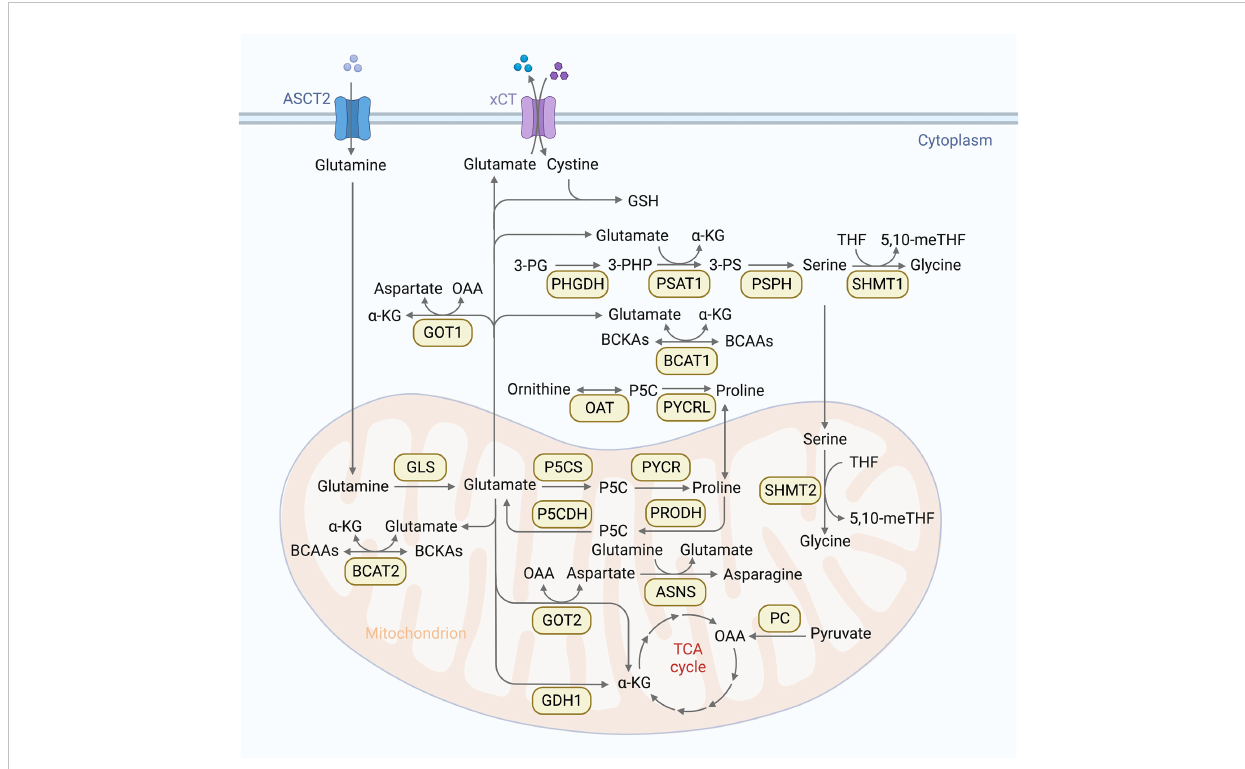
FIGURE 1 Overview of amino acid metabolic pathways. Cells absorb glutamine through the glutamine transporter ASCT, then glutamine is converted into glutamate through deamination catalyzed by glutaminase (GLS1/2) in mitochondria. Glutamate is further converted into a -ketoglutarate ( a -KG) by glutamate dehydrogenase (GDH) in mitochondria. a -KG can promote oxidative TCA cycle and participate a -KG dependent reactions as cofactor. Another TCA supplement way is that pyruvate carboxylase (PC) catalyzes pyruvate into oxaloacetate (OAA). In addition, glutamate and OAA can be reversibly converted into asparagine and a -KG by glutamic-oxaloacetic transaminase (GOT1/2). Furthermore, glutamate can be secreted by cystine antiporter xCT to transport cystine into cells. Glutamate and cystine can produce glutathione (GSH) to rescue cancer cells from oxidative